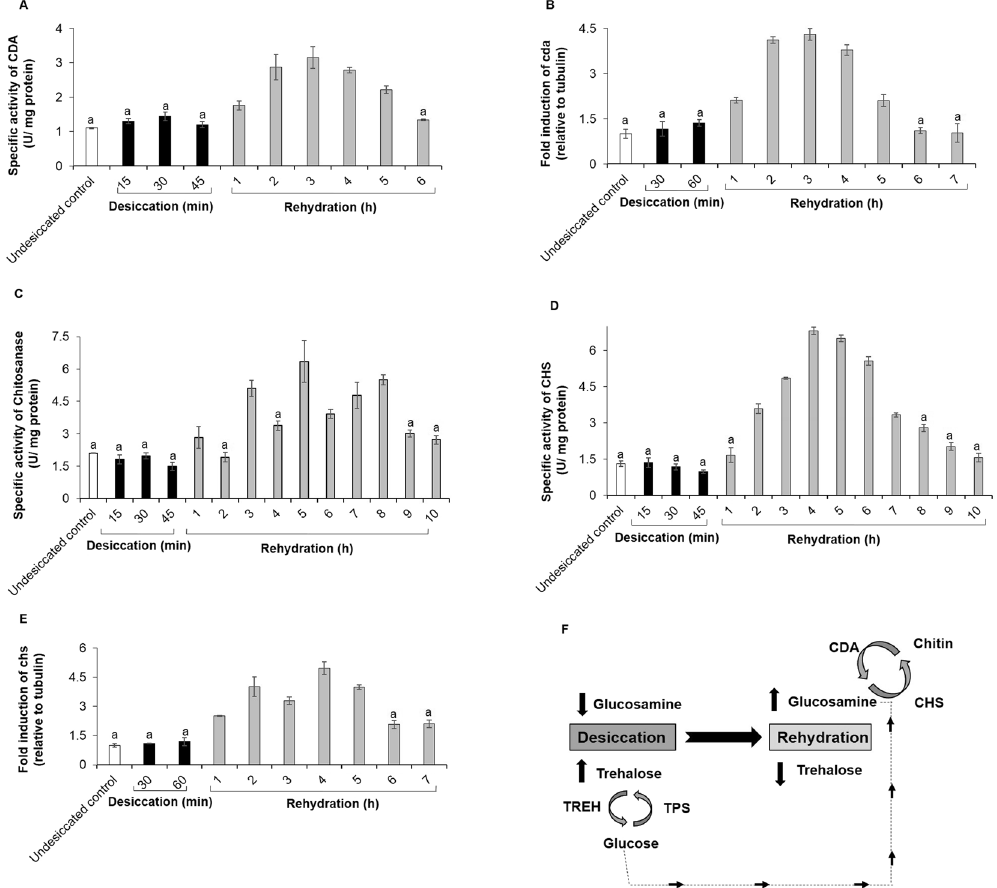
Figure 5. Involvement of the chitin metabolic pathway and working model underlying the basis of desiccation tolerance. ( A ) CDA enzyme activity. Data represented are mean ± SD of eight replicates (a = p < 0.05 vs 3 h rehydration). ( B ) Fold induction of cda transcripts. Data represented are mean ± SD of eight replicates (a = p < 0.05 vs 3 h rehydration). Undesiccated control values were set to 1 against which all other values were compared. The results were represented as fold induction relative to tubulin. ( C ) Chitosanase enzyme activity. Data represented are mean ± SD of eight replicates (a = p < 0.05 vs 5 h rehydration). ( D ) Chitin synthase enzyme activity. Data represented are mean ± SD of eight replicates (a = p < 0.05 vs 4 h rehydration). ( E ) Fold induction of chs transcripts. Data represented are mean ± SD of eight replicates (a = p < 0.05 vs 4 h rehydration). Undesiccated control values were set to 1 against which all other values were compared. The results were represented as fold induction relative to tubulin. ( F ) Schematic depicting the collaborative interplay of key biomolecular players namely, trehalose, chitin and glucosamine implicated during desiccation tolerance in C. ramosus